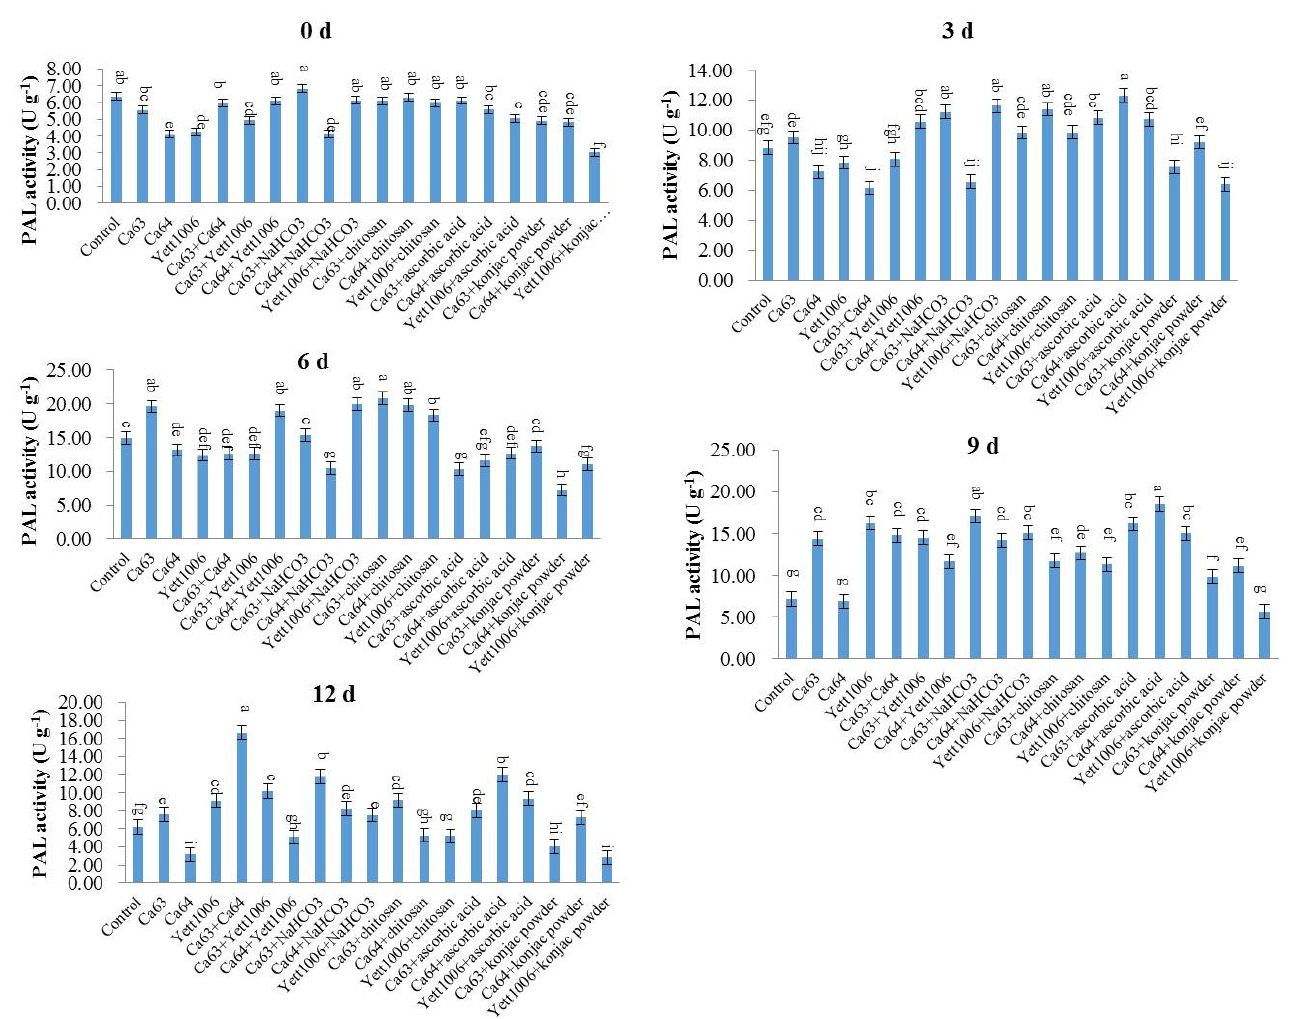
Figure 11. Evaluation of PAL activity in snap beans between different treatments. Error bars represent the standard deviations of means ( n = 3). On the bars, the small letters indicate a significant difference in the treatment according to Duncan’s multiple difference test ( p < 0.05).